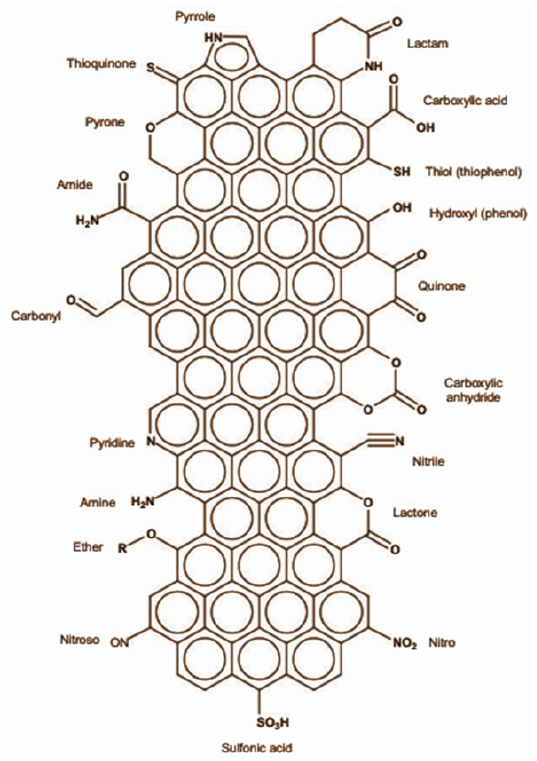
Figure 13. Illustration of surface functionalities that can be introduced in porous carbon materials. Adapted with permission from ref. [59].